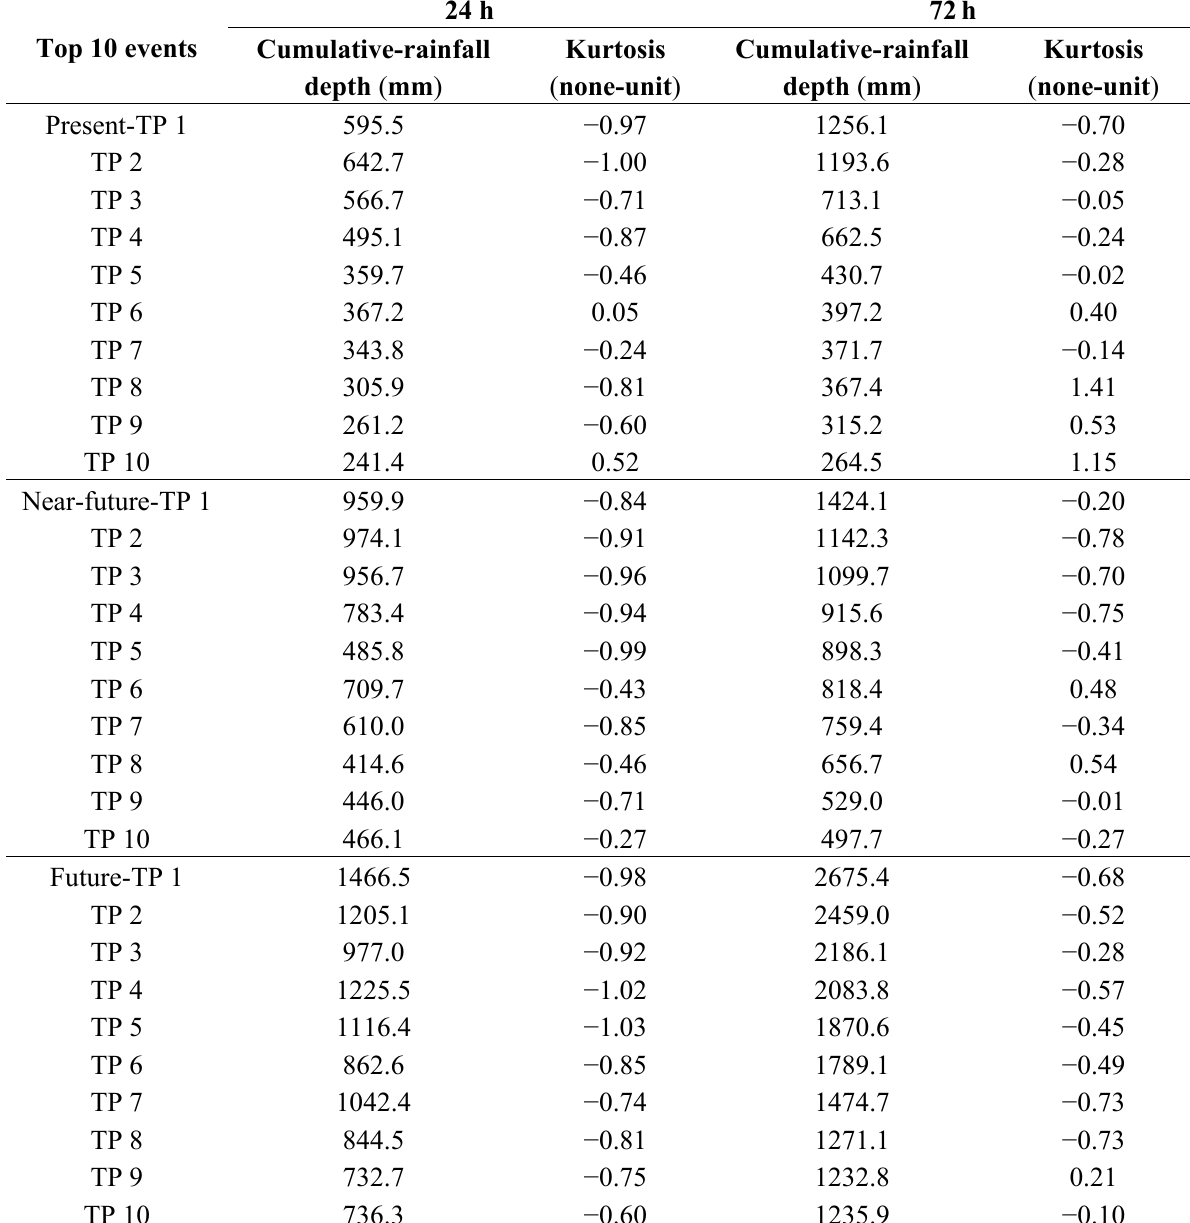
Table 3. Cumulative-rainfall depth and Kurtosis ( Kurt ) for design hyetograph with the modified ranking method coefficients for the Present, Near-future, and Future terms. Note that the values associated with the design hyetograph were averaged over the upper stream area from the dam